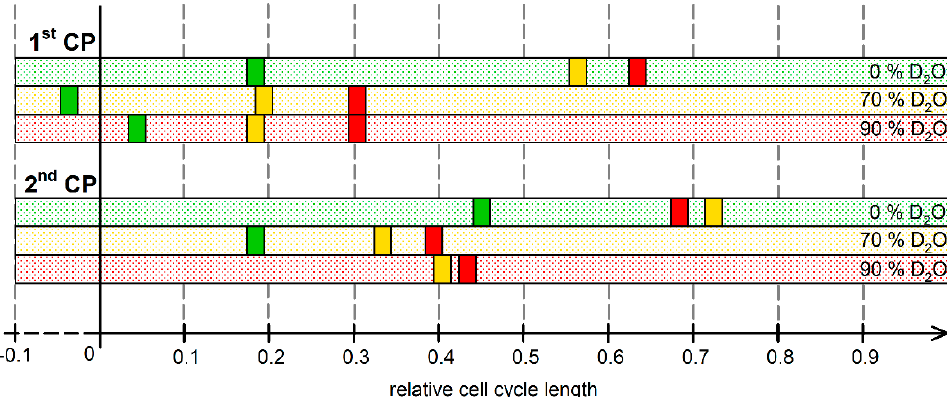
Figure 6. Midpoints of commitment point (CP) attainment in C. reinhardtii grown in D 2 O represented by relative cell cycle length. The three concentrations of D 2 O used for growth in the light are represented by three colored bars for the 1st CP and 2nd CP, respectively. Within each triplet, individual bars represent growth conditions as indicated on the right; green, yellow and red bars are assigned to growth in 0% D 2 O, 70% D 2 O and 90% D 2 O, respectively. Within each of the bars, midpoints of commitment point attainment after transfer to the dark to 0% D 2 O (green rectangles), 70% D 2 O (yellow rectangles) or 90% D 2 O (red rectangles) are displayed, indicating the relative incidence of the event within the cell cycle timeline. The midpoint of the second CP for the culture grown in 90% D 2 O and transferred to 0% D 2 O was not reached in the culture and therefore it is missing in the diagram (missing green rectangle in lowermost red bar).